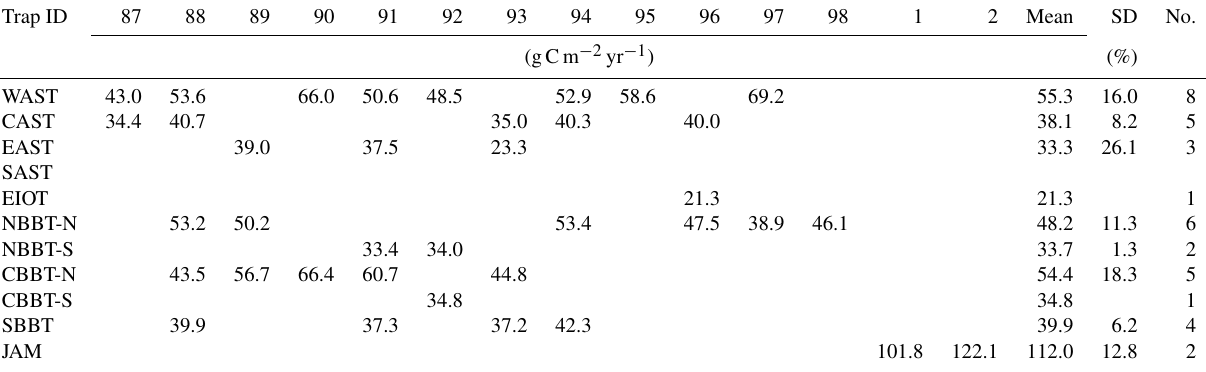
Table 3. Annual mean total fluxes measured at the trap sites during the years 1987 to 2002 in gCm − 2 yr − 1 , including the mean and the standard deviation as well as the number of years (no.) in which particle fluxes were measured for more than 255daysyr − 1 . For calculating the long-term average, data obtained in years in which fluxes were measured for fewer than 255 days were omitted. Trap